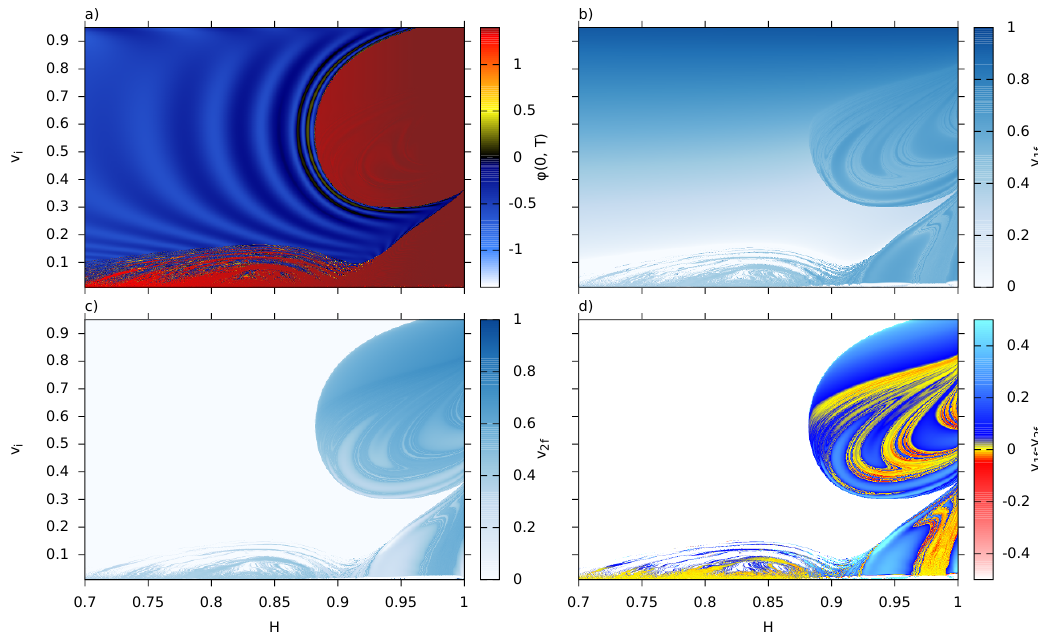
Figure 10 . Antikink-boundary scattering at large H . (a): a zoomed-in view of (cid:12)gure 3 showing the value of the (cid:12)eld at x = 0 a time t f = j x 0 j =v i + 100 after the start of the simulation; (b): the measured (cid:12)nal velocity of the re(cid:13)ected antikink; (c): the measured (cid:12)nal velocity of the emitted kink, if present, white being plotted otherwise; (d): the di(cid:11)erence between these two velocities.